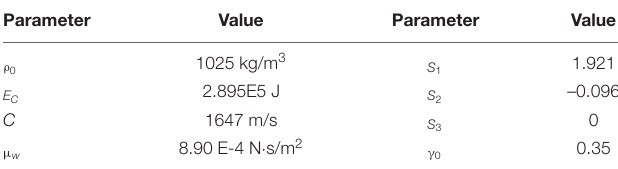
TABLE 1 | Sea ice parameters. TABLE 2 | Fluid parameters applied in the Grüneisen equation.